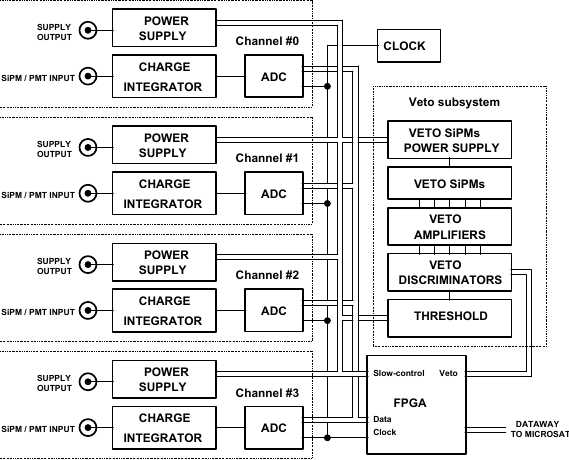
Figure 8. Block diagram of the payload electronics needed to operate the reference